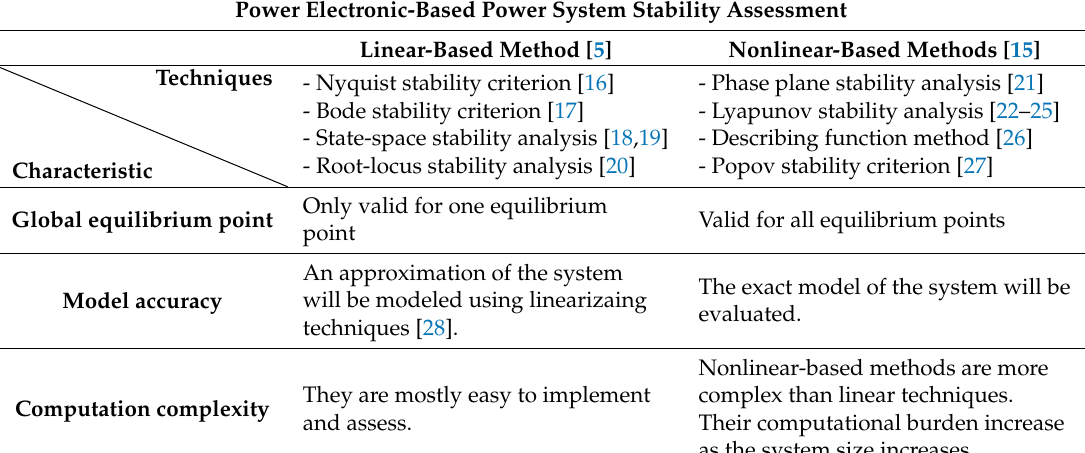
Table 1. Power Electronic-based power system stability techniques and their